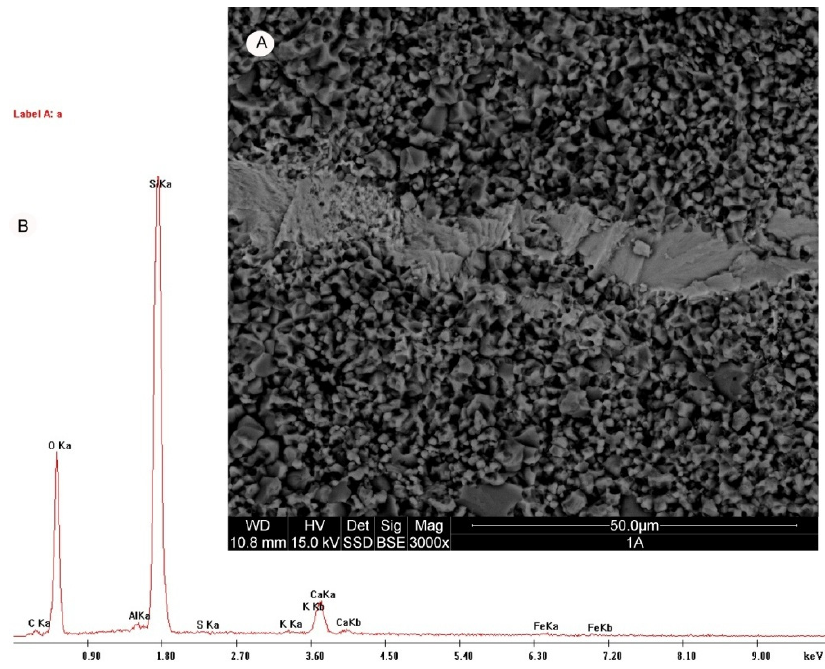
Figure 2. Tectonic fractures filled with an opal-like phase: ( A ) Image SEM, ( B ) Spectrum EDX. X-ray examination identifies the opal-filling tectonic fractures as an intermediate phase between opal-CT (cristobalite–tridymite) and opal-C (cristobalite) (Figure 3). In scanning images, it is noted in massive crystalline aggregates, with traces of dissolution visible in many places.